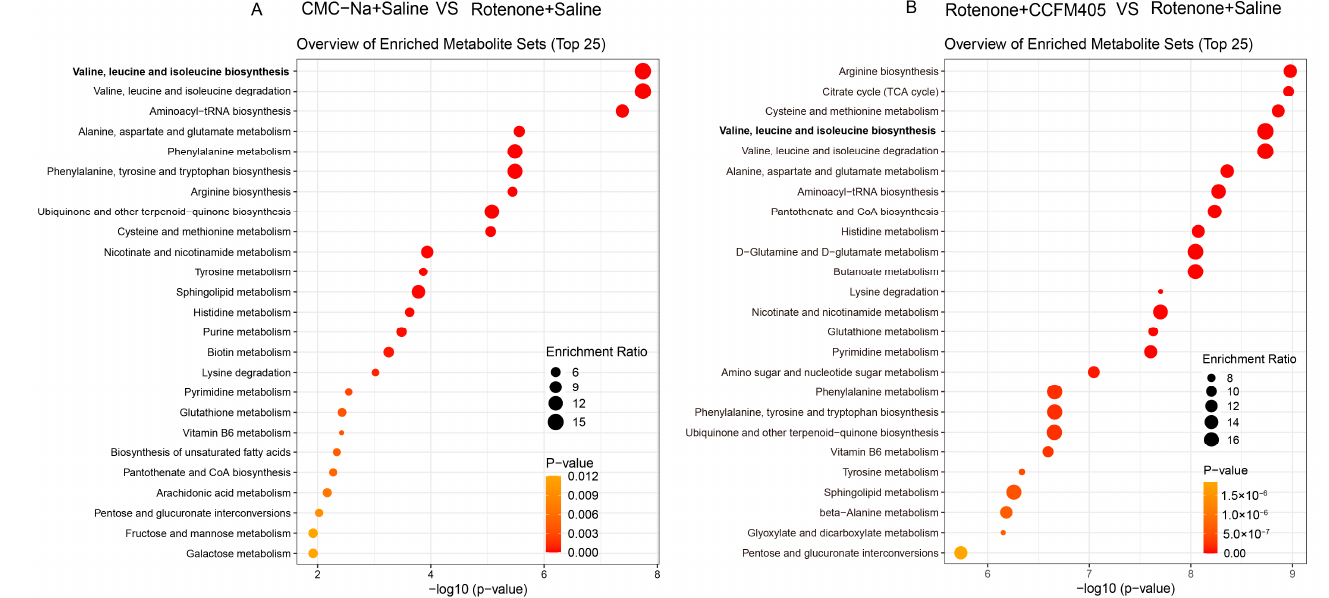
Figure 10. Metabolic pathway enrichment analysis of differential fecal metabolites. ( A ) Normal control versus PD group; ( B ) L. plantarum CCFM405 group versus PD group. The color of the histogram represents the metabolic enrichment pathways with significant differences. The size of the dots in the left panel means the enrichment rate, n = 10/group.